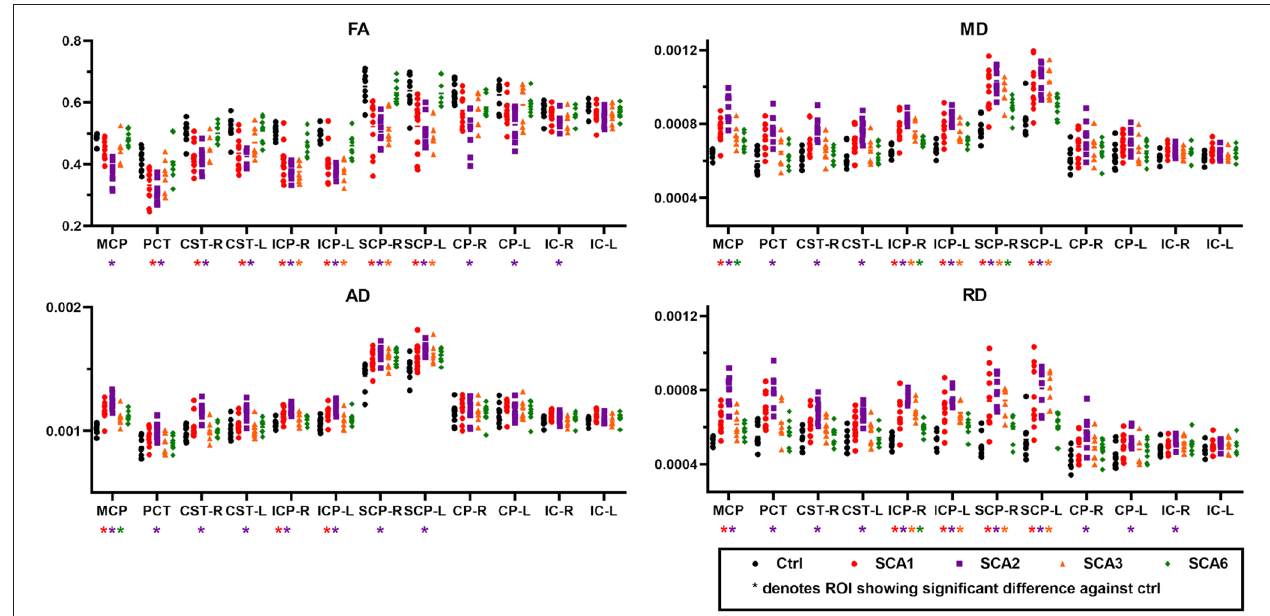
FIGURE 2 | Diffusion MRI metrics from different regions-of-interest (ROI). Cross-sectional ROI analysis highlights significant differences for fractional anisotropy (FA, upper left), mean diffusivity (MD, upper right), axial diffusivity (AD, lower left), and radial diffusivity (RD, lower right) between SCAs and control groups. Abbreviations shown in the figure are as follows. MCP, middle cerebellar peduncle; PCT, pontine crossing tract; CST-R and CST-L, right and left corticospinal tract; ICP-R and ICP-L, right and left inferior cerebellar peduncle; SCP-R and SCP-L, right and left superior cerebellar peduncle; CP-R and CP-L, right and left cerebral peduncle; IC-R and IC-L, right and left internal